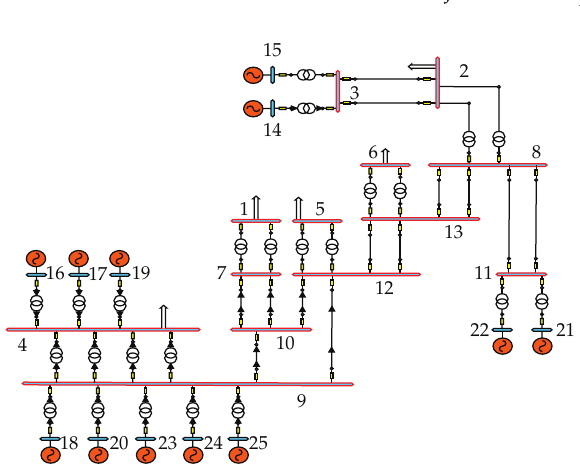
Figure 3: Single line diagrams for the 25-bus equivalent practical power system.